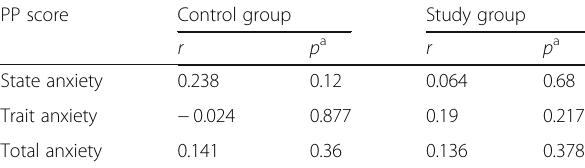
Table 5 Relationship between anxiety and PP scores Table 6 Pearson correlation analysis of trait anxiety and